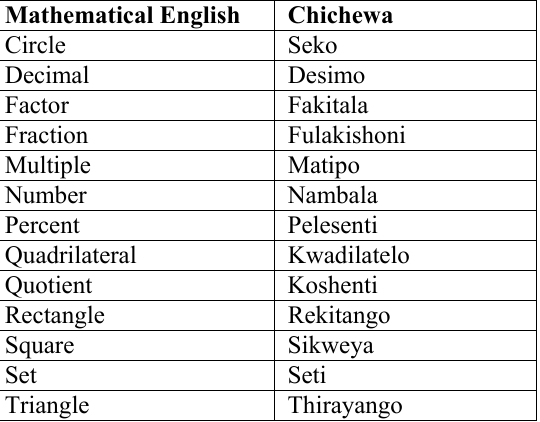
Table 3: Sample of mathematical terminology in